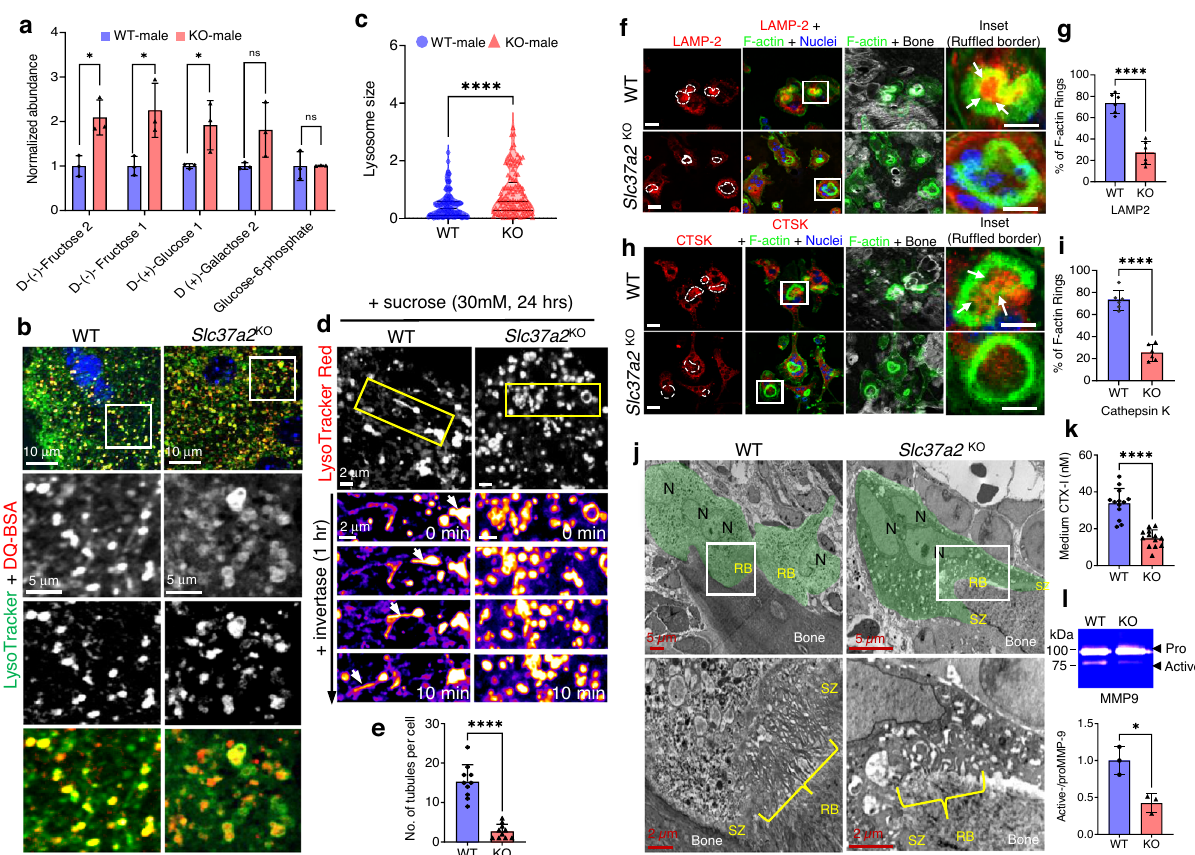
Fig. 9 | Export of monosaccharides and delivery of SLs to the ruf fl ed border is impaired Slc37a2 KO osteoclasts. a Quantitative metabolomics pro fi ling of mono- saccharidesugarsinBMM-derivedosteoclastsfromWTand Slc37a2 KO mice( n =3; D - ( − )-Fructose 2 P =0.014536; D -( − )-Fructose 1 P =0.028321; D -(+)-Glucose 1 P =0.046169). b and c Representative confocal images of WT and Slc37a2 KO osteoclastsstainedwith LysoTracker Greenand DQ-BSA ( b ) and quantitation ofSL size ( c ) ( n =109 SLs pooled from 10 cells per group, P <0.0001). d Time-lapse confocal image series of WT and Slc37a2 KO osteoclasts cultured in high sucrose conditions (30mM, 24h) to induce sucrosome formation and imaged for 10min post-treatment with invertase (0.5mg/ml, 1h). SLs were pulsed with LysoTracker Redpriortoimaging.ArrowstrackanSLresolutionandtubulationevent. e Number of tubules per cell post-treatment with invertase ( n =10 cells, P <0.0001). f – i